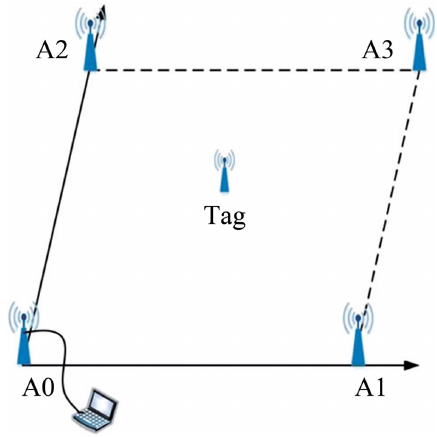
Figure 2. Location diagram based on UWB.